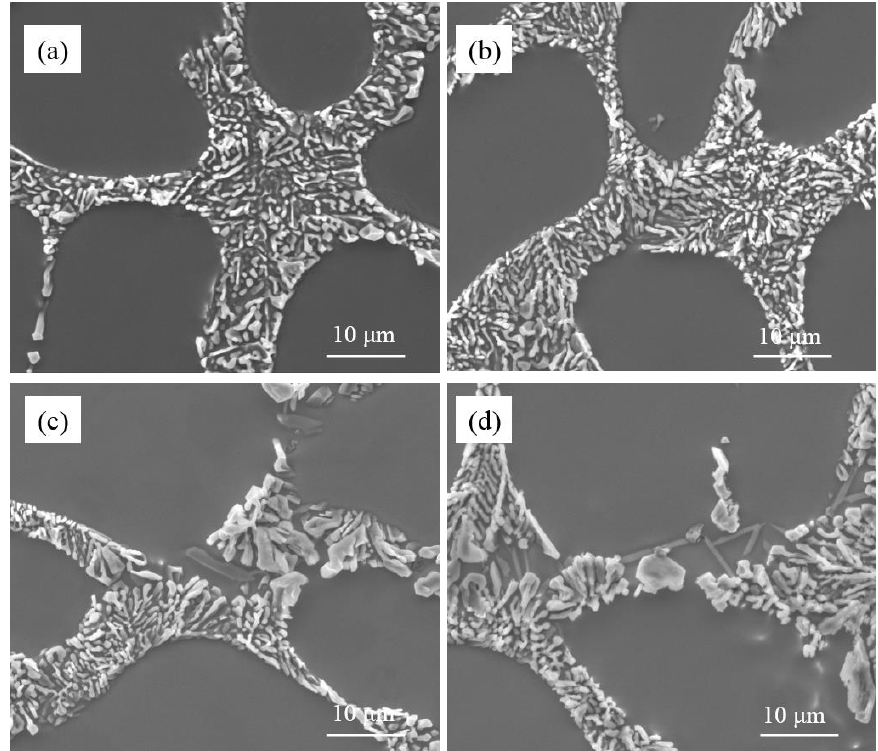
Figure 5. Microstructure of commercial pure Al-7Si alloy and Al-7Si-0.4Mg alloy with different Sr additions; ( a , b ) Al-7Si alloy; ( c , d ) Al-7Si-0.4Mg alloy; ( a , c ) with 0.03 wt.% Sr; ( b , d ) with 0.06 wt.% Sr.